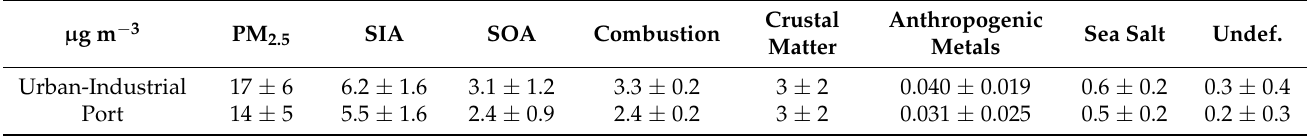
Table 4. Mean mass concentration ( µ g m − 3 ) and standard deviation of PM 2.5 and of the main mass classes: secondary inorganic aerosol (SIA), secondary organic aerosol (SOA), combustion, crustal matter, anthropogenic metals, sea salt, and the undefined mass